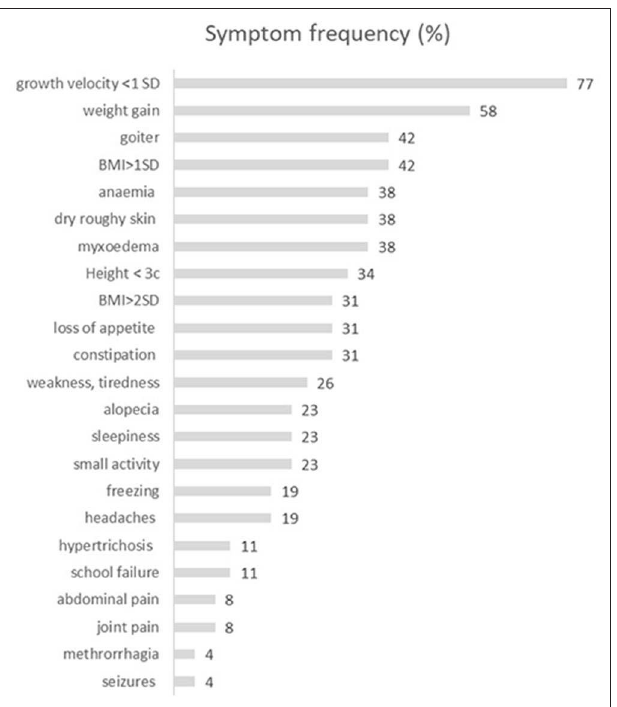
FIGURE 1 | The characteristics of the frequency of symptoms reported by patients with severe hypothyroidism. BMI, body mass index [kg/m 2